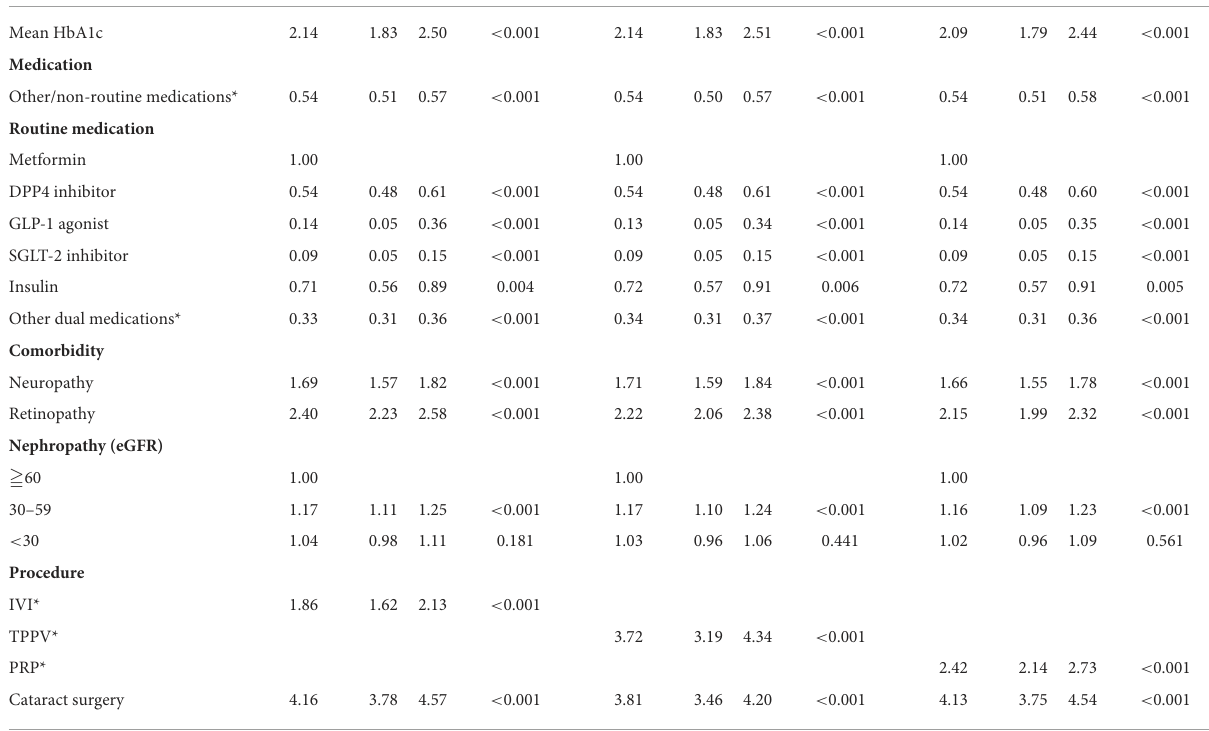
TABLE 5 Risk and protective factor analysis for dry eye disease using the conditional logistic regression model with control of age, sex, and